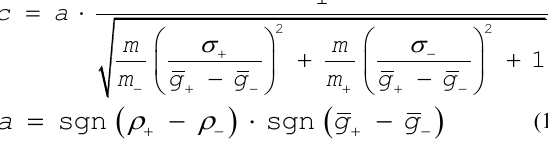
where ρ + – value of “ on ” mask, ρ - – value of “ off ” mask, g mean value of intensity values in the image covered by “ on ” mask, g – mean value of intensity values in the image covered  by “ off ” mask, m + – number of “ on ” pixels in the mask, m - – number of “ off ” pixels in the mask, m – number of “ on ” and “ off ” pixels in the mask, σ + – standard deviation of intensity values covered by “ on ” mask, σ - – standard deviation of intensity values covered by “ off ” mask. Four corner types are assumed: upper left, upper right, lower right and lower left. Each type is correlated with the whole image and pixels which result in a correlation coefficient higher than our detection threshold are selected. The selected pixels are coded with the orientation attribute of primitive instances (“upper left”, “upper right”, “lower right” and “lower left”) and with its correlation coefficient c . In Fig. 2 exemplary corner detection is presented. For the red, green, blue and yellow pixels the correlation coefficient was higher than the detection threshold. Colours encode the orientation attribute. For a typical façade image some 20,000 such pixels remain from texture of e.g. in this case 1024 x 524.